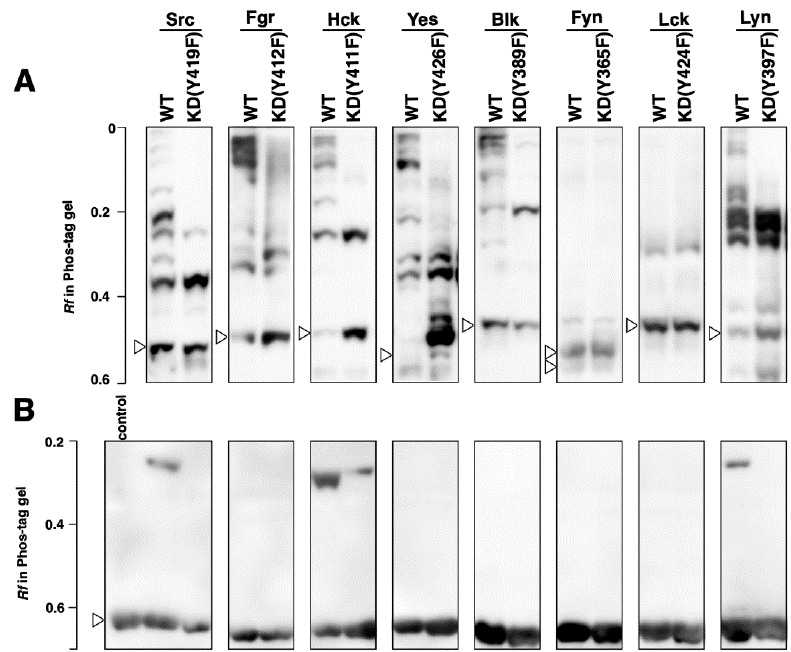
Figure 2. Phosphorylation status and tyrosine kinase activity of SFKs expressed in 293 cells. ( A ) Phosphorylation status of the wild-type (WT) SFKs and the corresponding kinase-dead (KD) mutants expressed in 293 cells were analyzed by Phos-tag SDS-PAGE (7% w / v polyacrylamide, 20 µM Zn 2+ –Phos-tag), followed by Western blotting with anti-FLAG antibody. The open arrowheads show the positions of the unphosphorylated forms. ( B ) The SFKs expressed in 293 cells were purified by immunoprecipitation with anti-FLAG antibody-bound magnetic beads and then subjected to an in vitro GST-Srctide phosphorylation assay. Each reaction was performed for 60 min. Reactions were analyzed by Phos-tag SDS-PAGE (10% w / v polyacrylamide, 20 µM Zn 2+ –Phos-tag), followed by Western blotting with anti-GST antibody. The open arrowhead shows the positions of the unphosphorylated GST-Srctides.